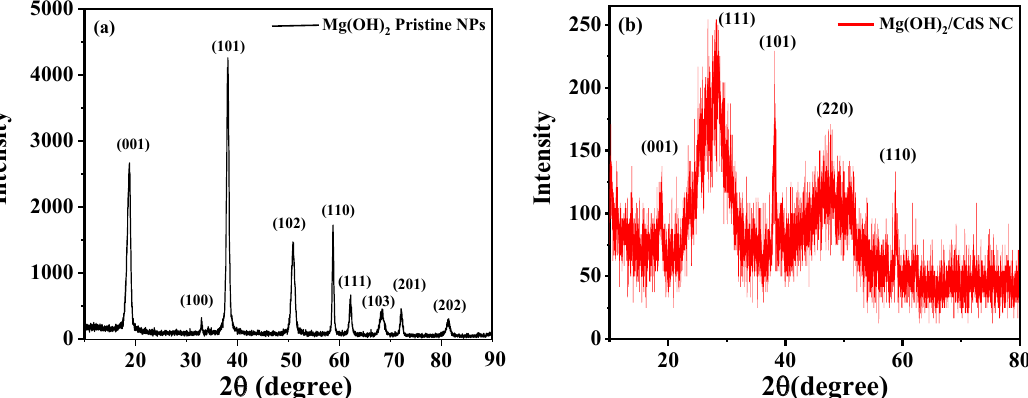
Fig. 1. XRD patterns of (a) pristine Mg(OH)